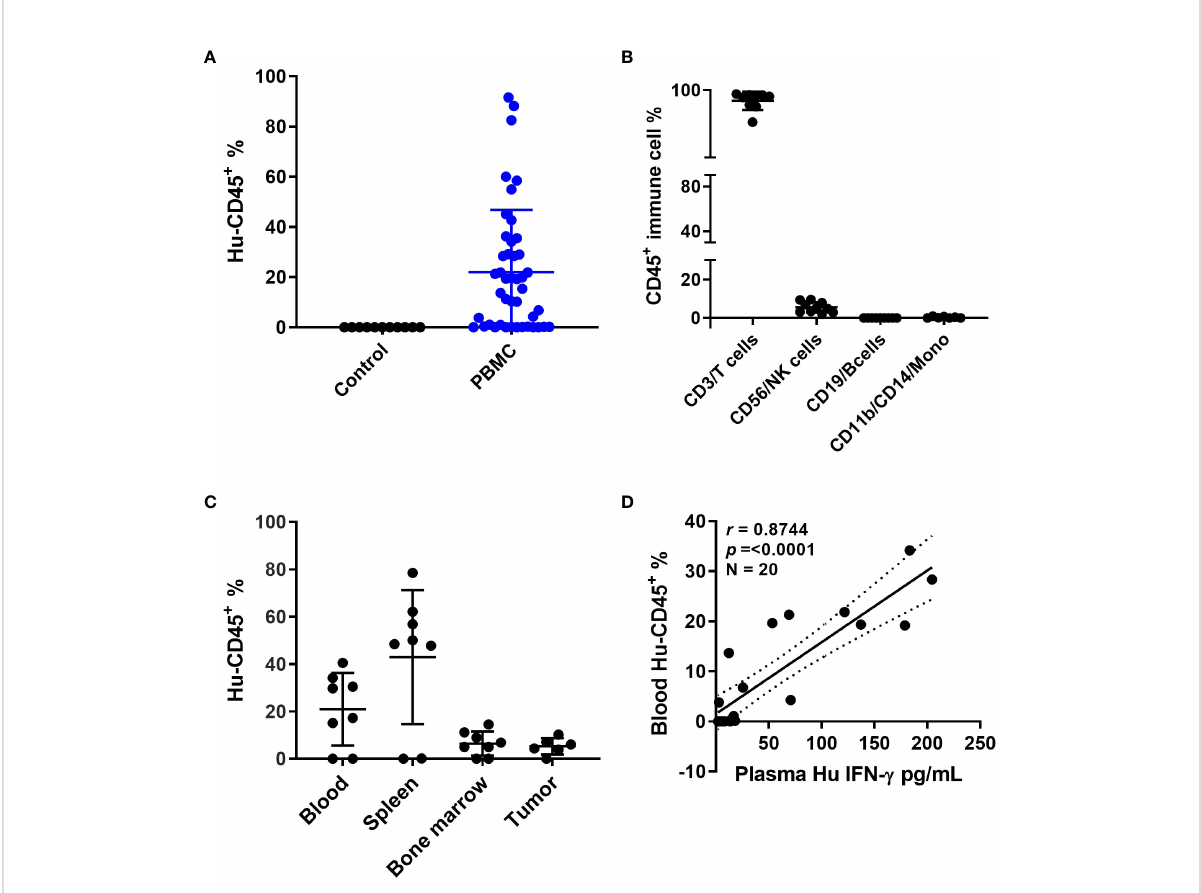
FIGURE 1 Humanized mouse development and characterization (A) Human CD45 + cell% engraftment in mice 5 weeks after injection of human PBMCs. (B) Different immune cell percentages in mouse blood 5 weeks after PBMC injection. (C) Human CD45 + cell percentage in different mouse tissues. (D) Correlation between human CD45 cell percentage in mouse blood and human interferon (IFN)- g levels in mouse